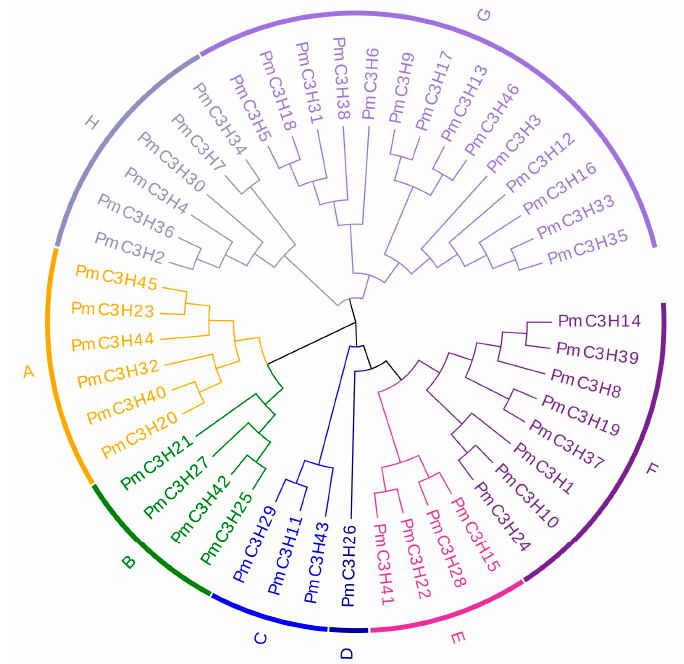
Figure 1. Phylogenetic analysis of CCCH proteins in P. massoniana . Gene names in different colors correspond to groups of the same color in the outermost circle. The group is named from “A” to” H”.